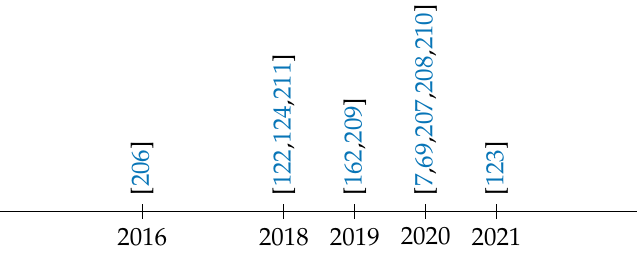
Figure 13. A timeline of different papers within the deanonymization of dark net users